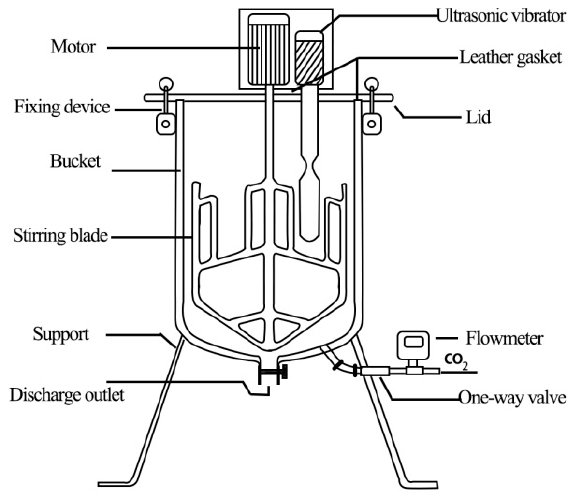
Figure 1. Schematic diagrams of ultrasonic agitation devices (reprinted with permission from Ref. [13].